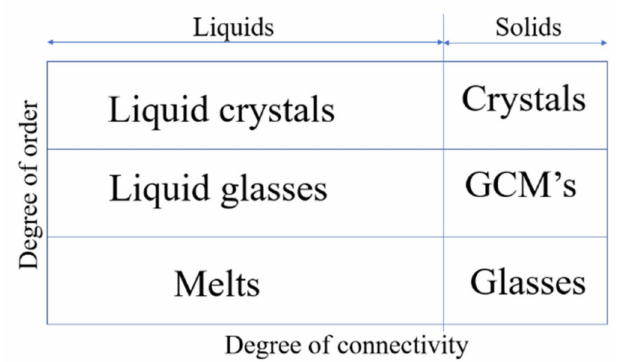
Figure 5. Schematic of phase state as function of ordering and connectivity between building blocks (molecules) of materials. GCMs are glass composite materials containing both crystalline and vitreous phases. Table 1. Critical parameters for 2 and 3-dimensional structures (sets). Dimension of System, d 3 (Bulky) 2 (Planar) Scher–Zallen critical density (invariant), θ